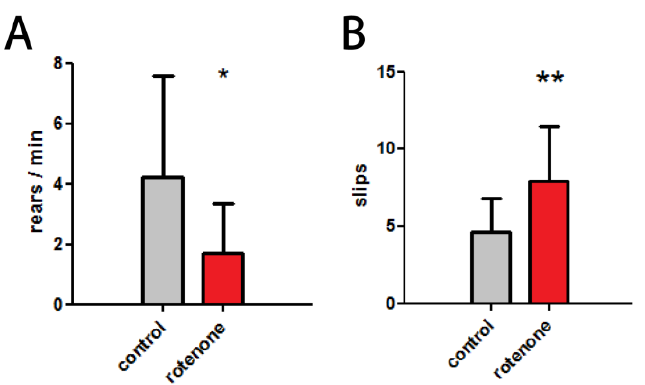
Figure 2. Development of PD-like symptoms in mice after 14 days of rotenone exposure. ( A ) The number of rears per minute in a cylinder test, * p < 0.05 ( B ) The number of paw slips (mistakes) in a beam walking test, ** p < 0.01.